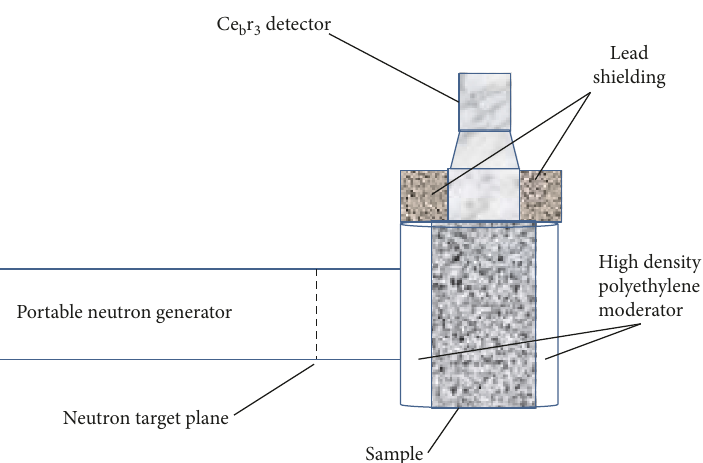
Figure 1: Schematic representation of the MP320 portable neutron generator-based PGNAA setup used to measure the prompt gamma-ray yields.